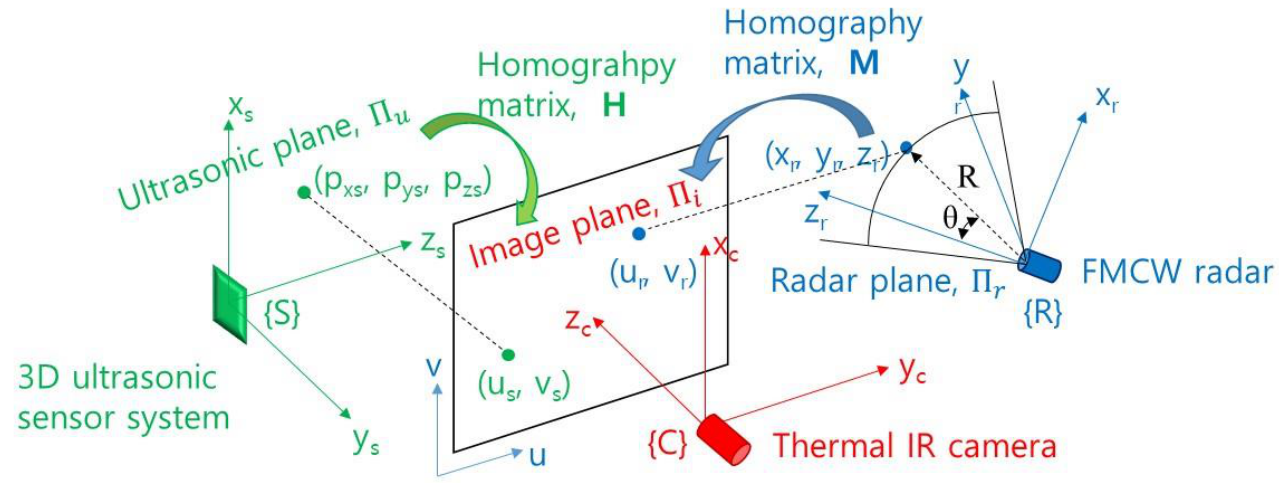
Figure 8. Sensor geometry and transformation .